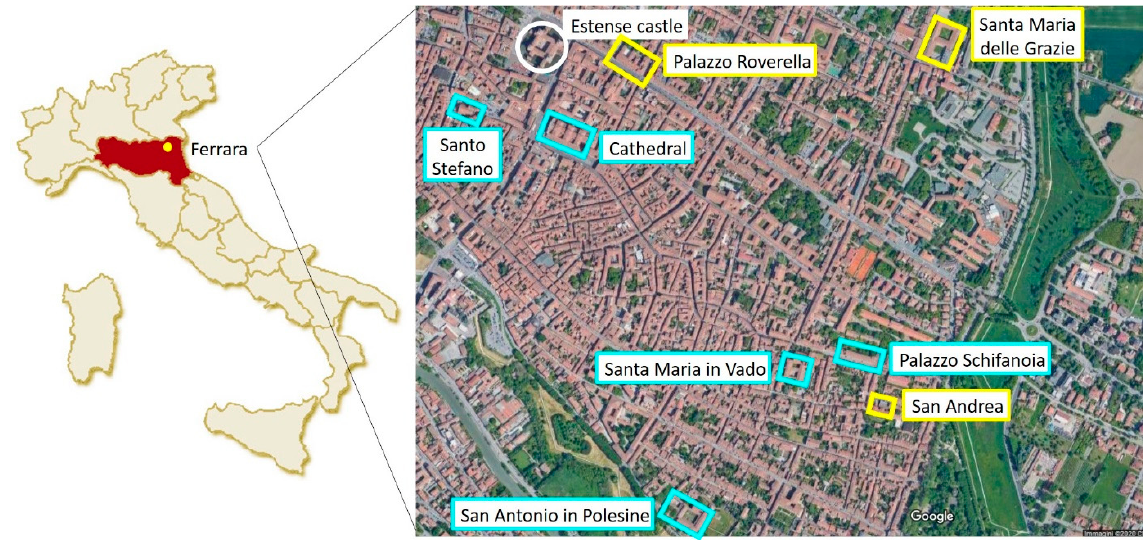
Figure 1. Map of the sampling sites in the city center of Ferrara. Colored in yellow the three different sampling sites: Palazzo Roverella, the cloister of the monastery of Santa Maria delle Grazie and the church of San Andrea. Colored in white the Ferrara castle that represents the main center of Ferrara and colored in light blue other historical buildings (the Cathedral, the church of Santo Stefano, the church of Santa Maria in Vado, the monastery of San Antonio in Polesine and Palazzo Schifanoia) whose XRF analyses were used for comparison.